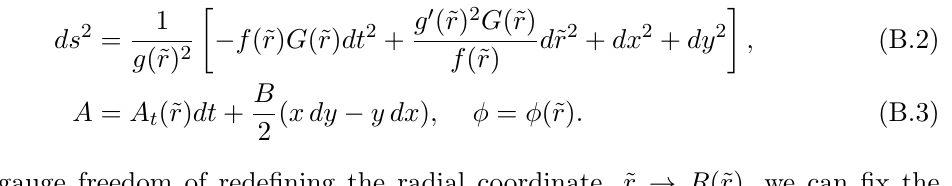
Figure 3 . Ricci curvature of the metric for the case (cid:13) = of AdS when the dilaton vanishes. Assuming a large value of the dilaton at the horizon u (cid:28) 1, they are well approximated by (5.33), as we will see D